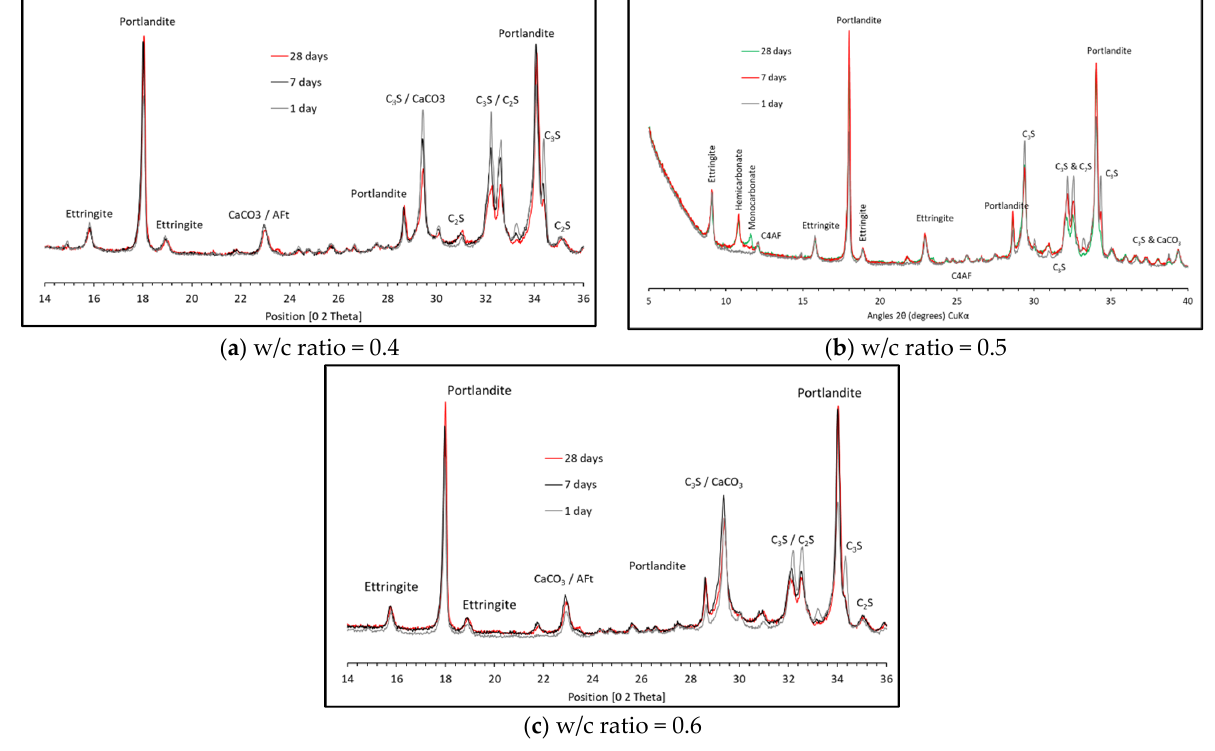
Figure 1. XRD patterns at 1, 7 and 28 days.